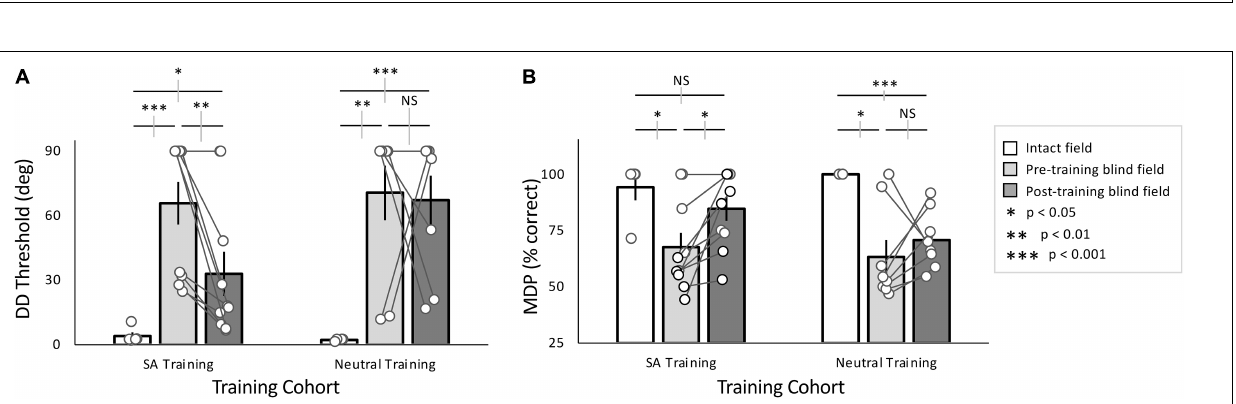
FIGURE 2 | Study and task design. (A) 12 Participants were recruited and split between 2 training cohorts. All participants were tested in-lab at baseline, then trained at home for several months, before returning to the lab for post-training measures. Two participants in the Neutral training and 1 participant in the SA training cohorts did not return and were lost to follow up. (B) In-lab tests used random dot stimuli moving coherently in a direction above or below the horizontal meridian, either to the left or right, to measure direction difference thresholds relative to the horizontal. Participants were only asked to report if motion direction was above or below the horizontal by pressing the up/down arrows on their keyboard, respectively. All testing was performed with eye-tracker enforced fixation control. (C) SA training was identical to the testing task, but additionally included a pre-cue at fixation (represented in red here, white in reality). The pre-cue lasted 200 ms, and was presented 500 ms prior to onset of the 2 stimuli. The SA pre-cue indicated the relative location of an upcoming target stimulus, which would appear in the blind field together with a second, non-target stimulus. The target stimulus, whose direction of motion (above or below the horizontal) the participant was required to indicate via key press, was denoted by a response cue presented simultaneously with the 2 stimuli. (D) Task sequence for Neutral training, which was identical to SA training, except that the pre-cue (red in diagram) did not indicate which of the 2 upcoming stimuli would be the target.